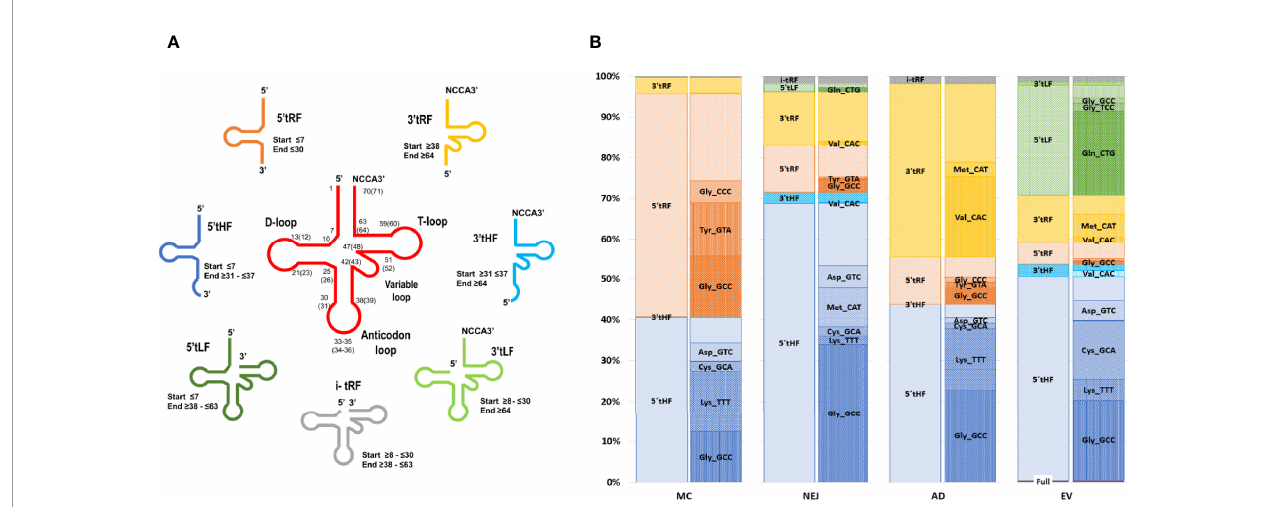
FIGURE 6 | Expression pro fi les across samples and folding of tRNAs-derived fragments. (A) Depiction of tRNA fragments detected in the study, a color code was used for each class. (B) Bar charts grouped by sample showing the percentage of each tRNA fragment class detected and proportion of individual fragments related to the tRNA of origin and the sequence of the